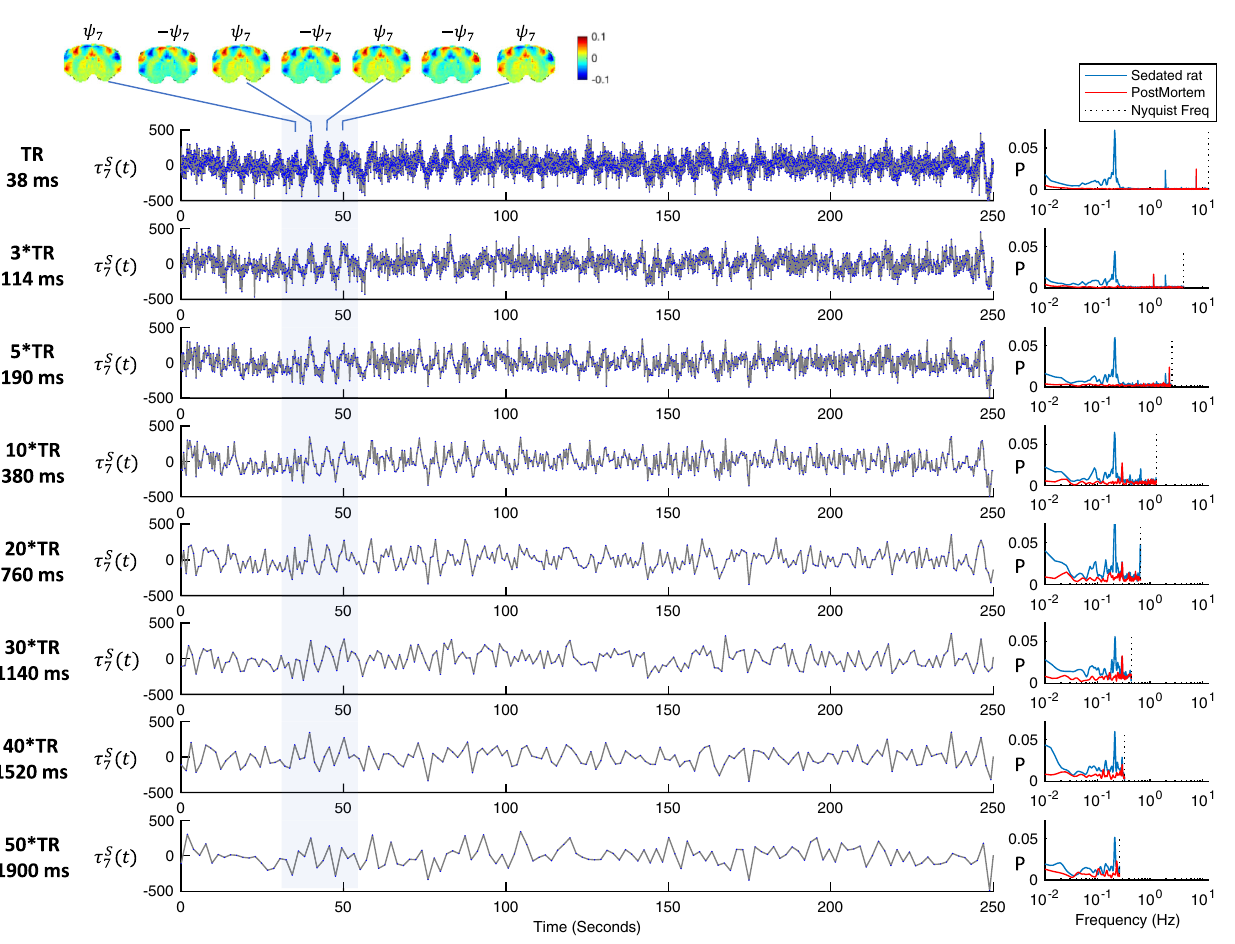
250s from a representative scan S (same as Fig. 3). Right: The power spectral density (PSD) of the sampled signals computed for scan S (blue) and for a scan performed postmortem (red). For each downsampling factor, both PSD (red and blue) are normalized by the total power in the postmortem scan. PSDs are com- puted over the entire scan duration of